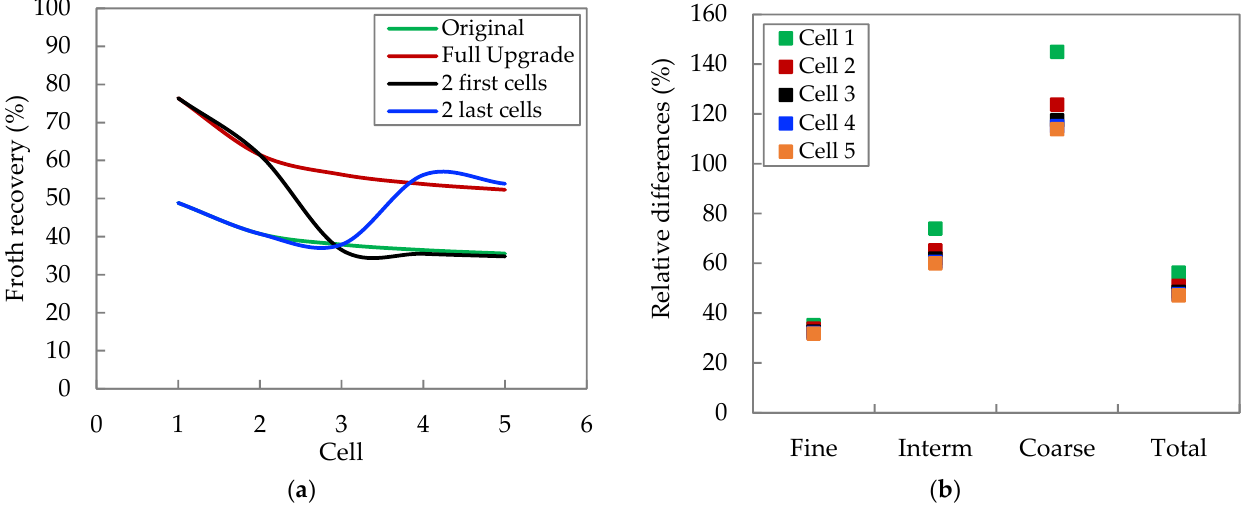
Figure 8. ( a ) Froth recovery along the bank for the four scenarios and ( b ) relative differences in froth recovery between standard and upgraded launders per particle size class.